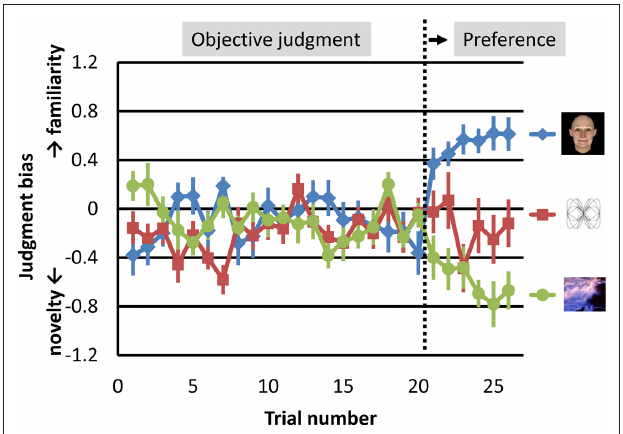
Figure 4 | Timelines of rating bias in experiment 2. Data points are trial-by-trial means of ratings rectified toward the repeated image. Error bars represent one standard error of the